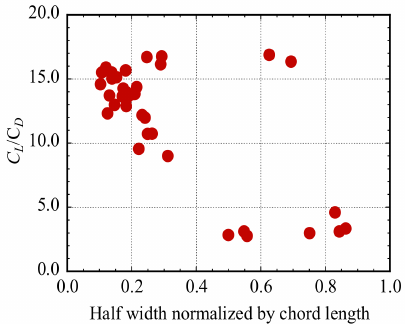
Figure 8. Aerodynamic performance versus rapidity of turbulent energy promotion in the chordwise direction: α = 12 ◦ , Re = 6.3 × 10 4